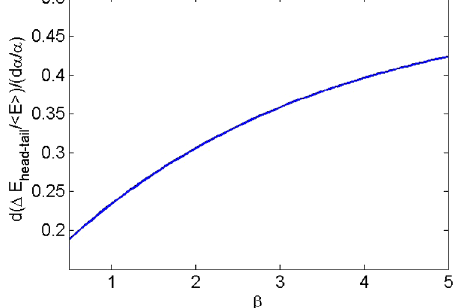
ns).FIG. 6. Sensitivity of the head-tail train energy spread with respect to the power ratio parameter α as a function of β